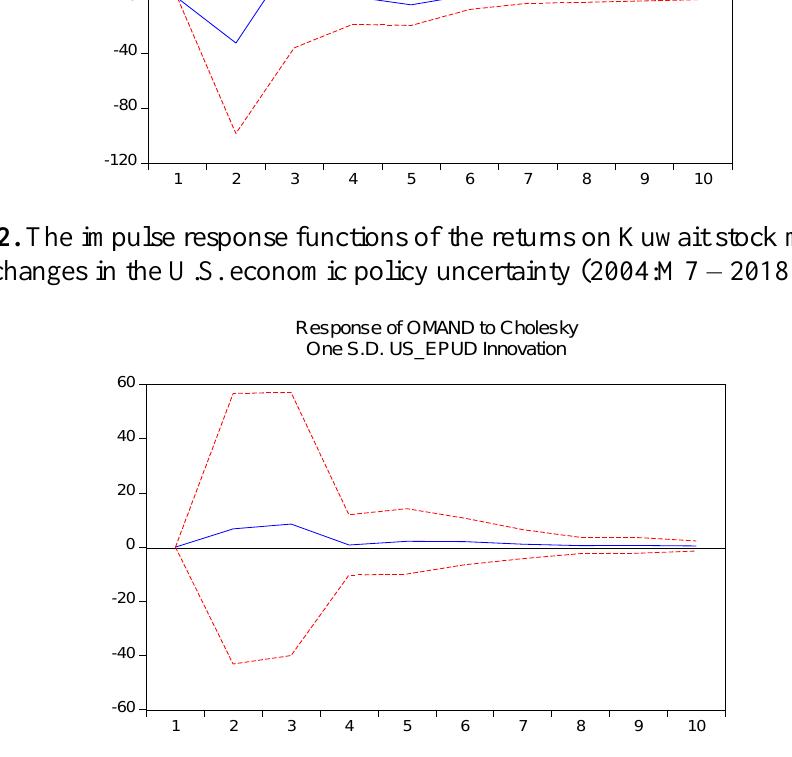
Fig. 3. The impulse response functions of the returns on Oman stock market to changes in the U.S. economic policy uncertainty (2004:M7 – 2018:M8)